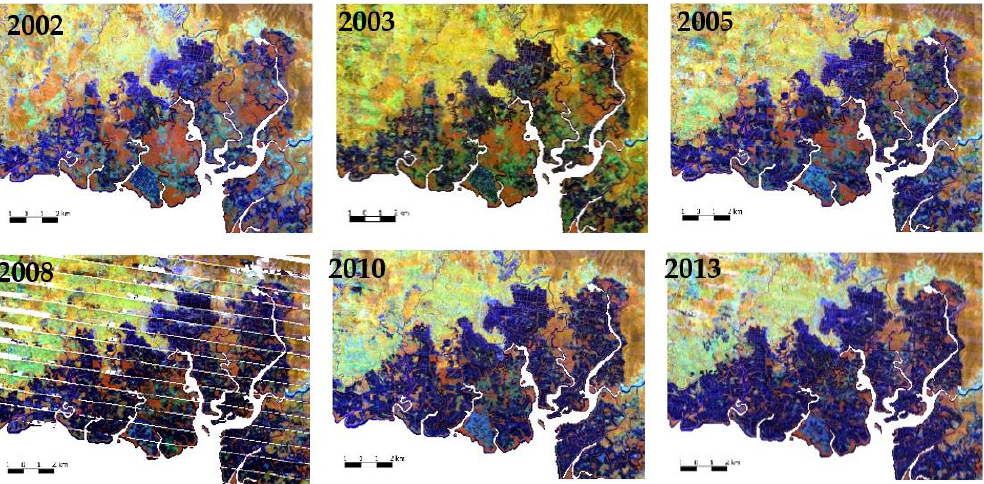
Figure 9. The effects of scanline errors in the Landsat-7 imagery.